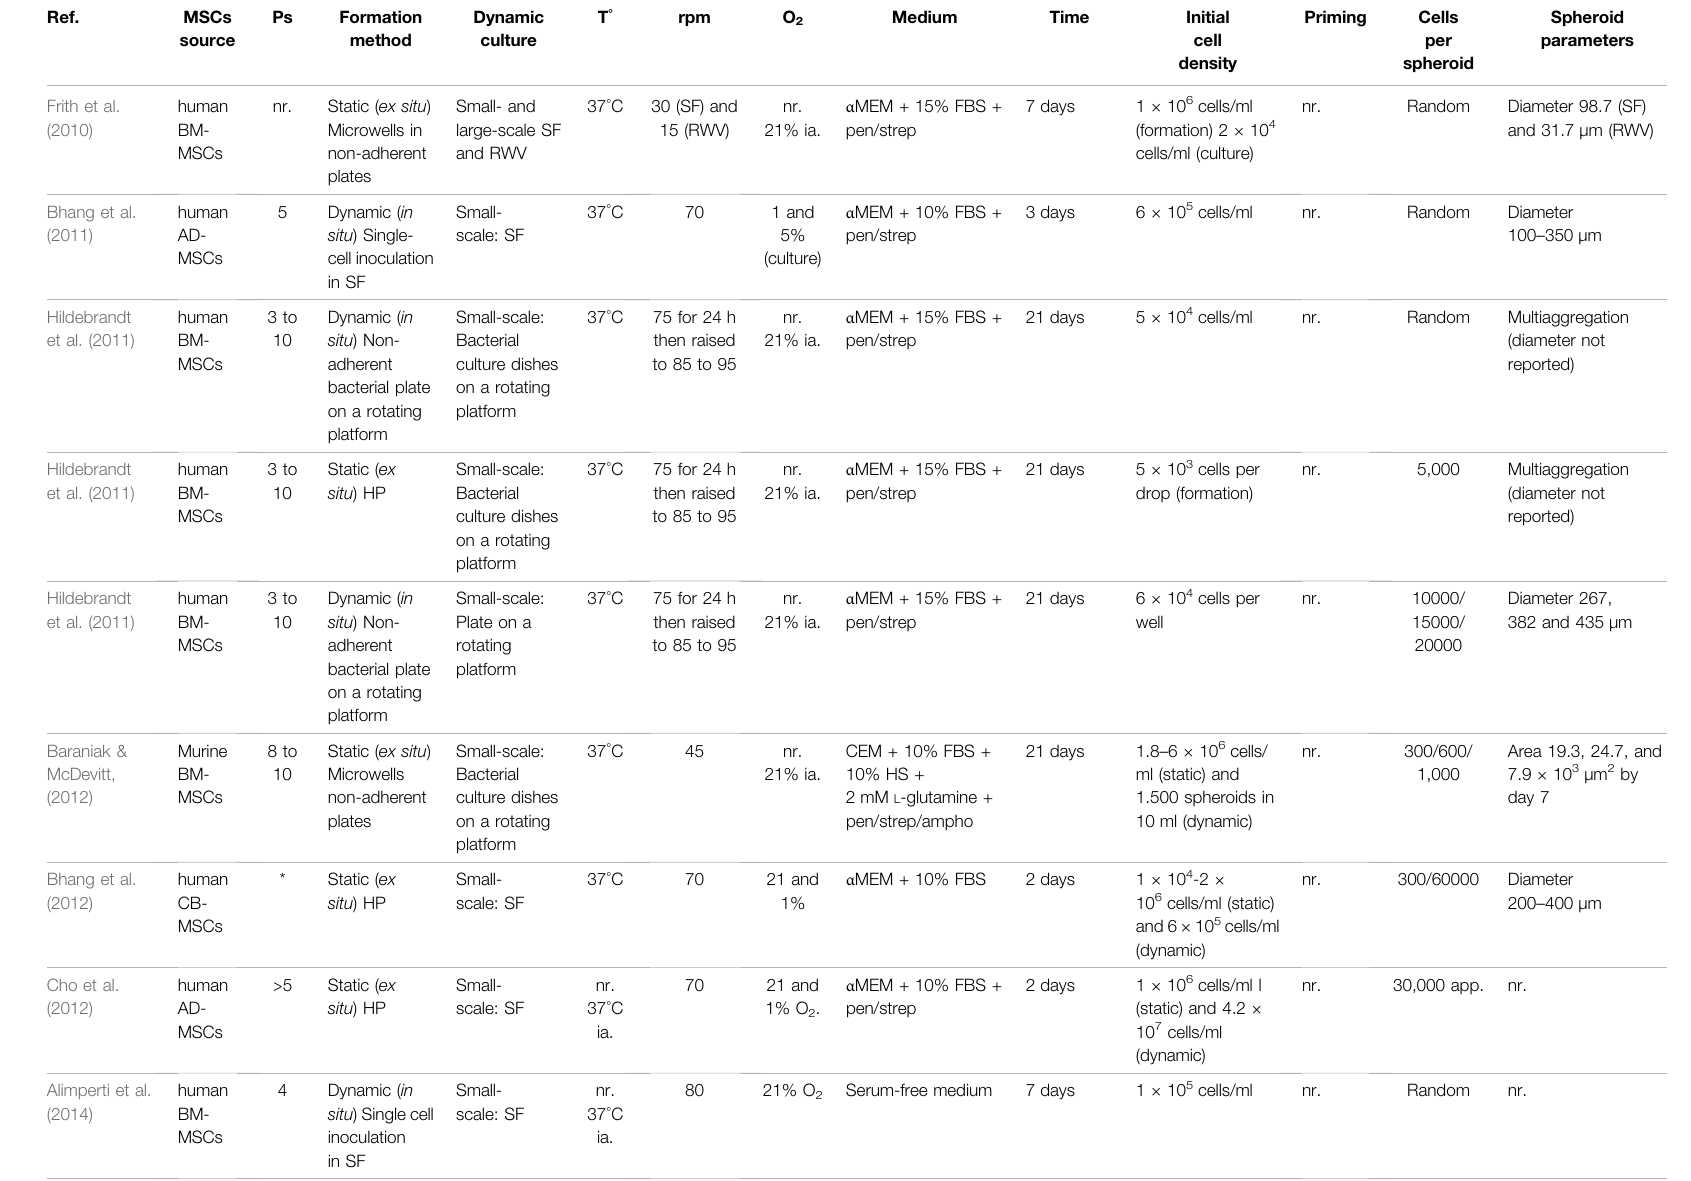
TABLE 1 | Comparison of different studies reporting static and dynamic methods of spheroid formation and their results for the dynamic cultivation of MSC spheroids.